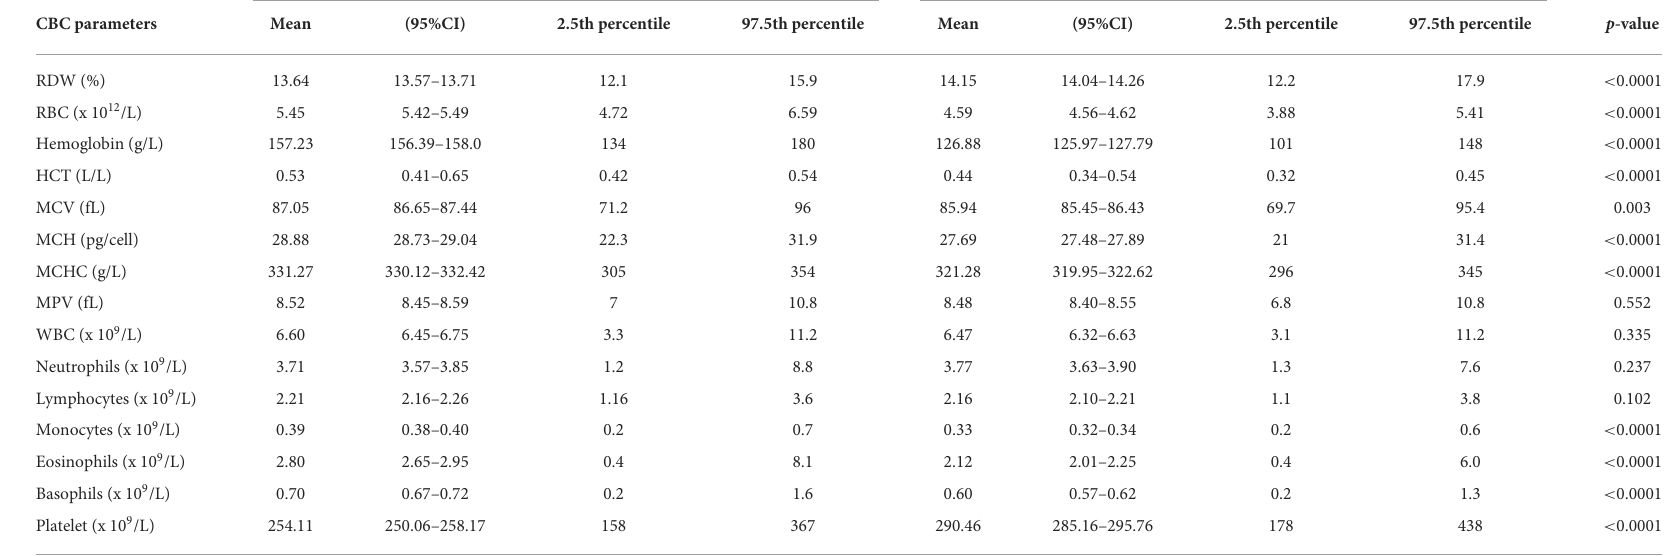
TABLE 1 Complete blood count (CBC) reference intervals of the study cohort by